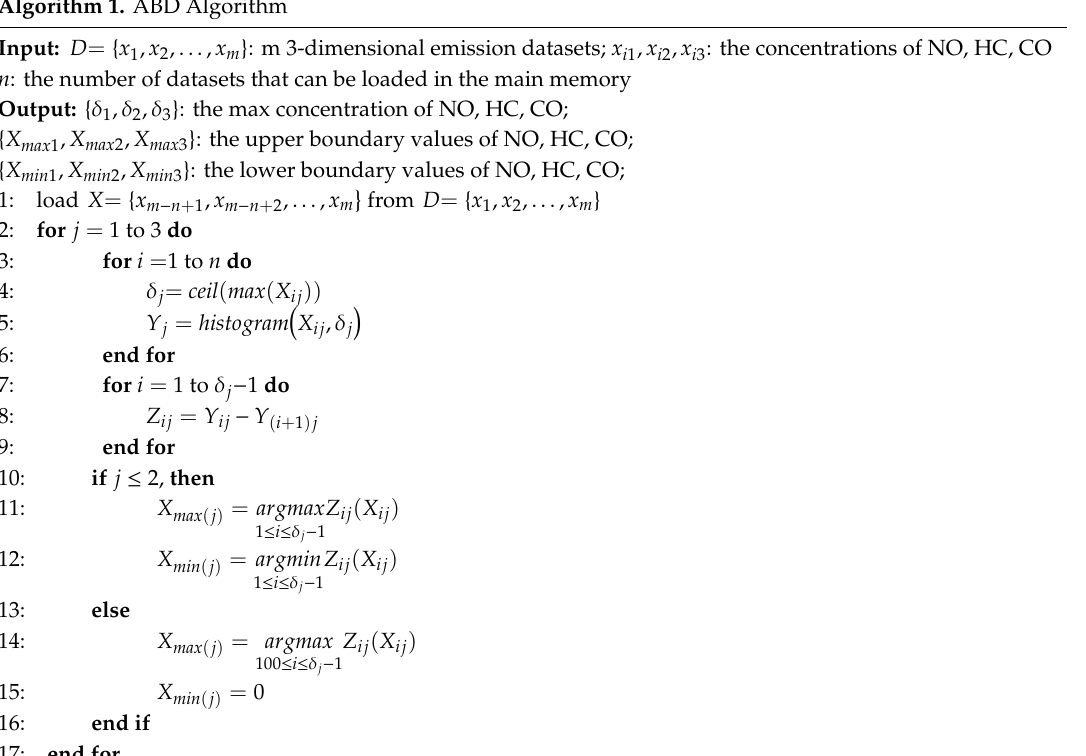
Algorithm 1. ABD